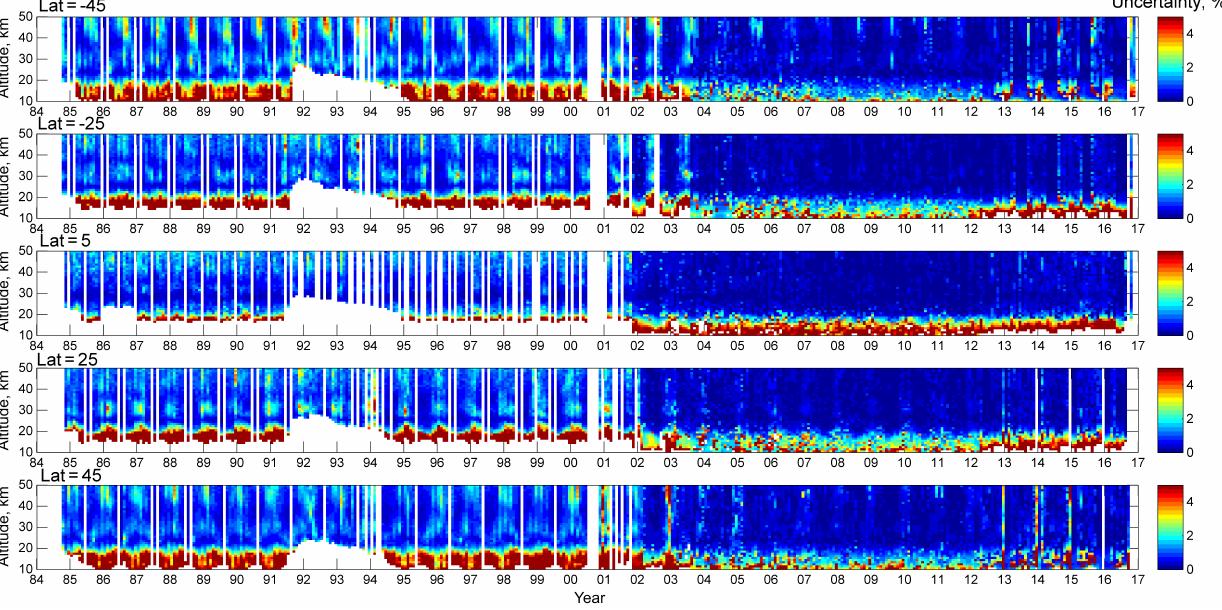
Figure 9. Uncertainties of the merged deseasonalized anomalies (%), Eq. (8), for several 10 ◦ latitude bands, centers of which are specified in the